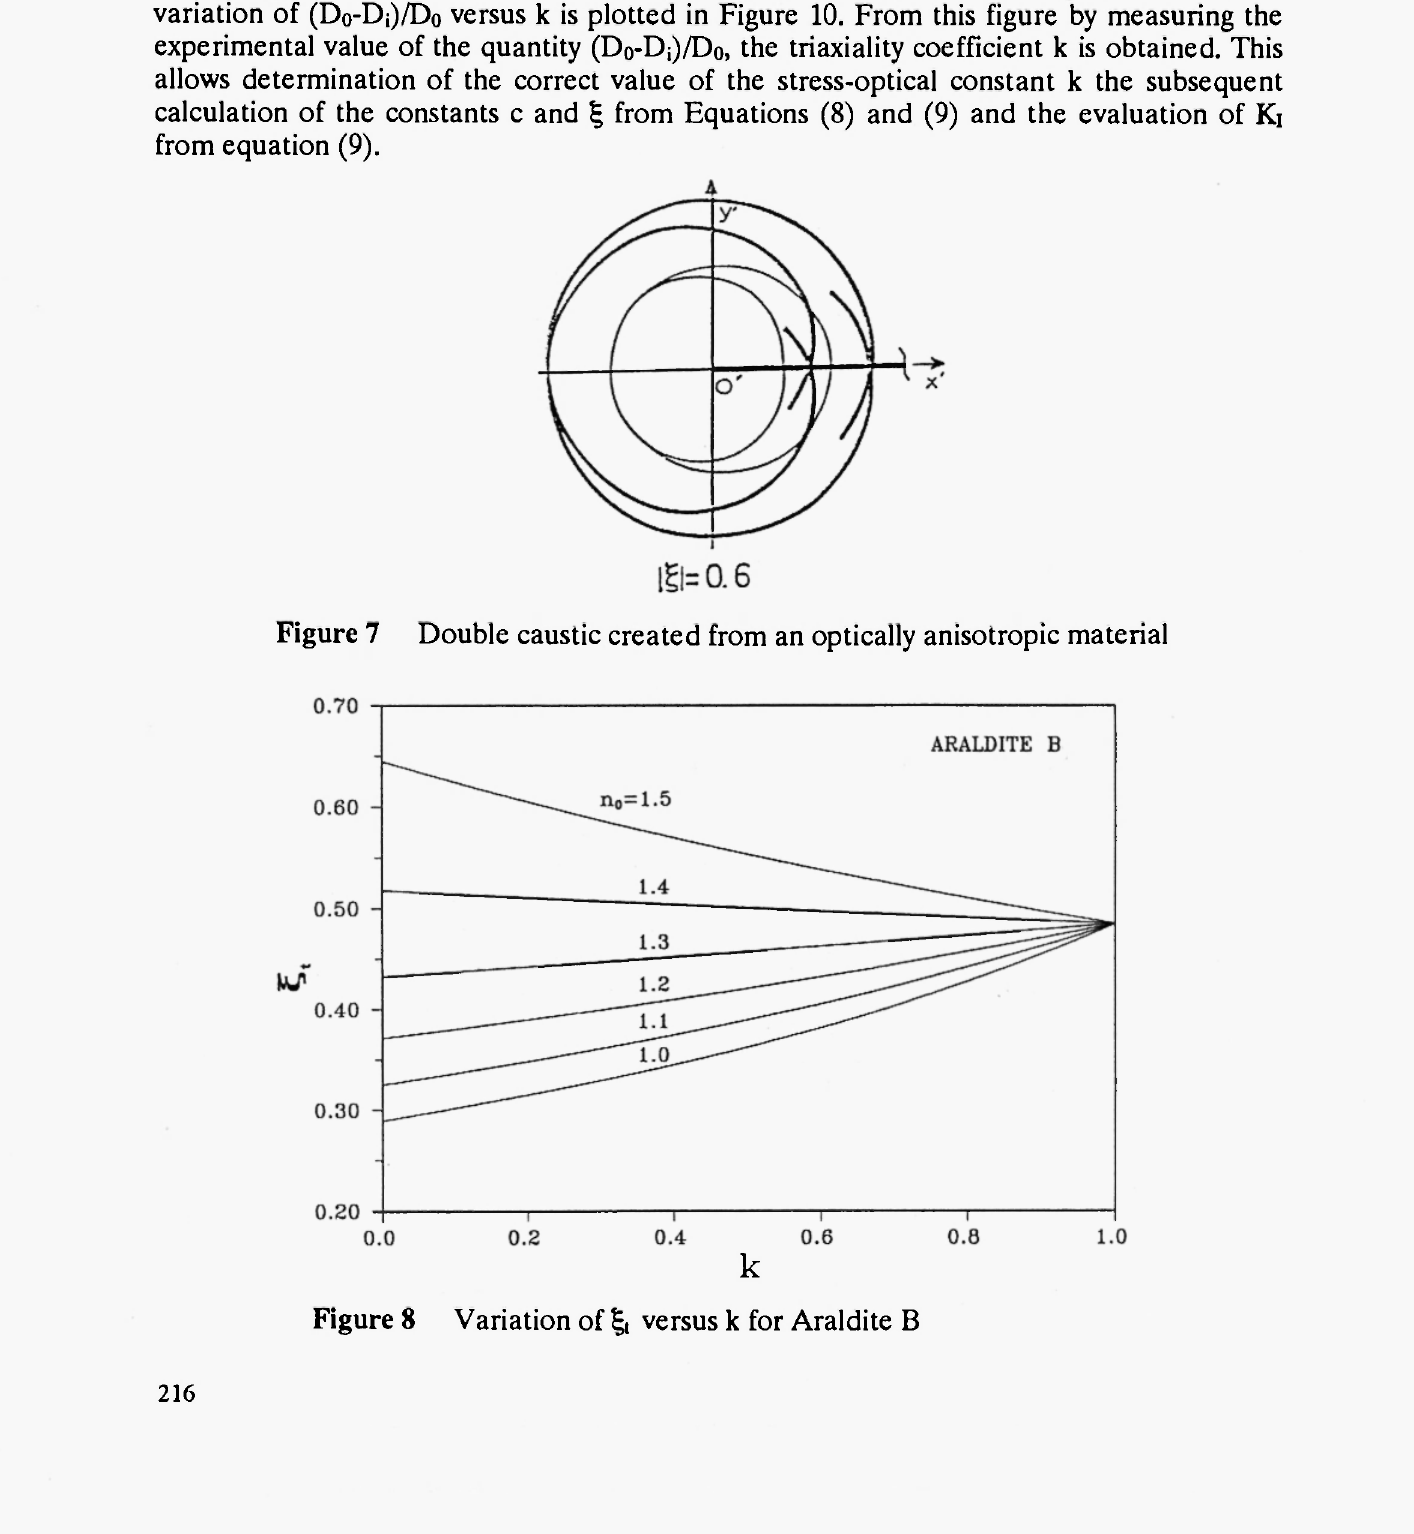
k versus k for Araldite (